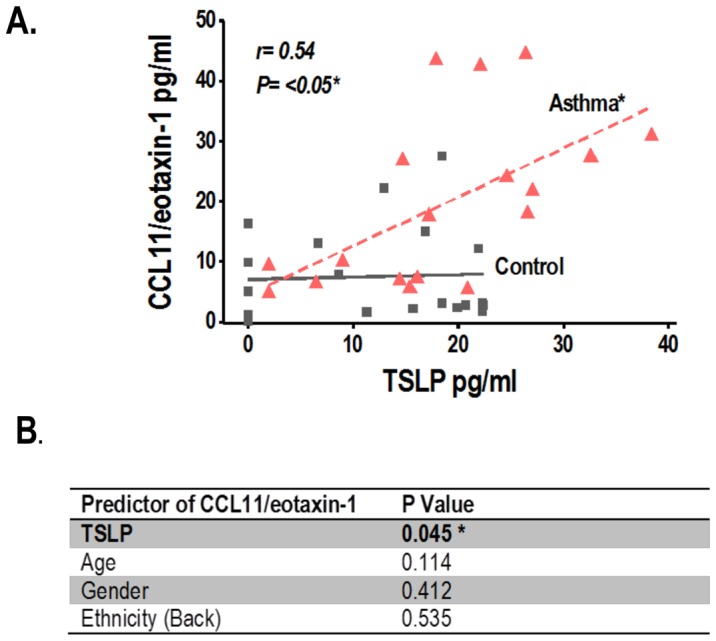
Linear correlation of TSLP and CCL11/Eotaxin-1 secretion during rhinovirus-induced asthma exacerbation.(A) Positive linear relationship of nasal airway protein levels of TSLP and CCL11/eotaxin-1 in subjects with rhinovirus-induced asthma exacerbation P<0.01 (r = Pearson correlation). (B) Multivariate linear analysis demonstrates that the link between TSLP and CCL11/eotaxin-1 in subjects with rhinovirus-induced asthma exacerbation (n = 20) is independent of age, gender and ethnicity. Values in boldface represent statistical significance (p<0.05).